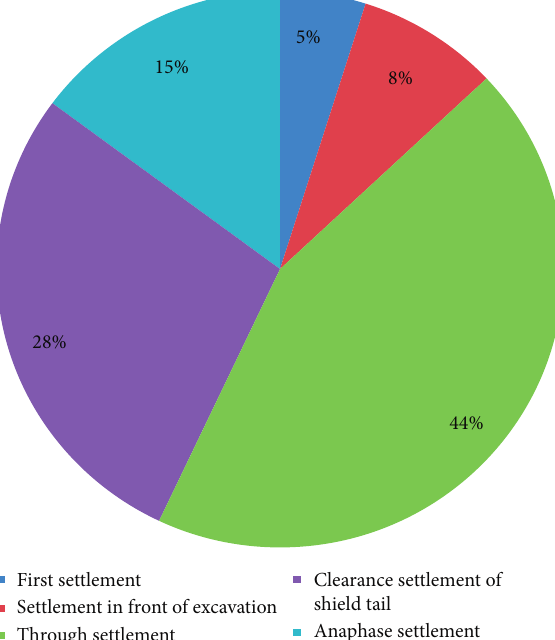
Figure 19: Settlement scale map of cross section 2 (grouting